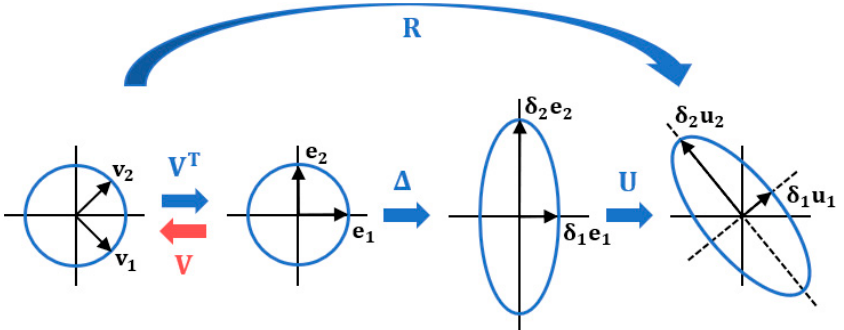
Figure 2. Geometric interpretation of the singular value decomposition (SVD) for a 2 × 2 matrix showing the linear transformation induced by matrix 𝑅 decomposed into three actions: a rotation, a scaling and another rotation (after [46,47]).